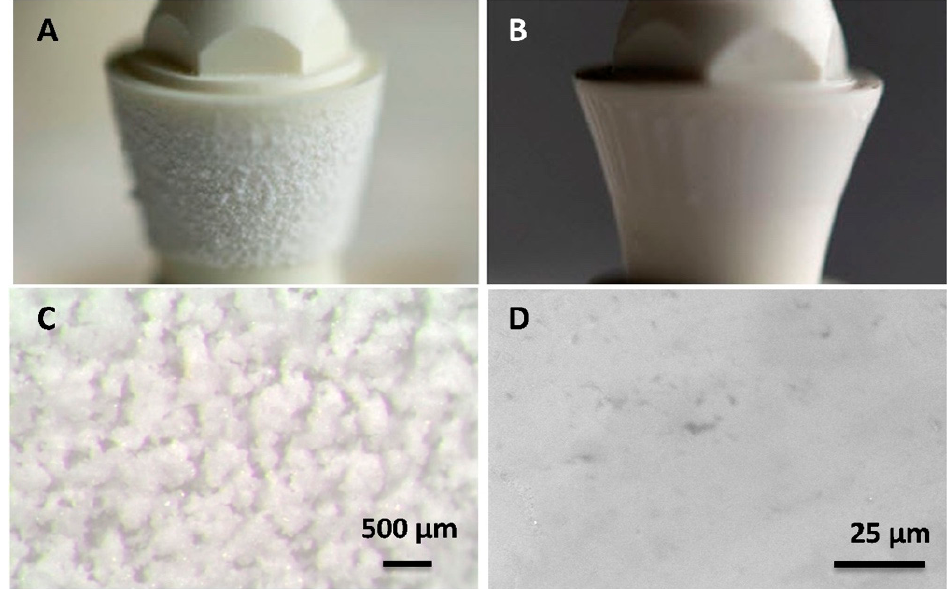
Figure 4. Coated abutments before (left) and after (right) thermal treatment. ( A , B ): General views. ( C , D ): Close-ups of the surfaces.